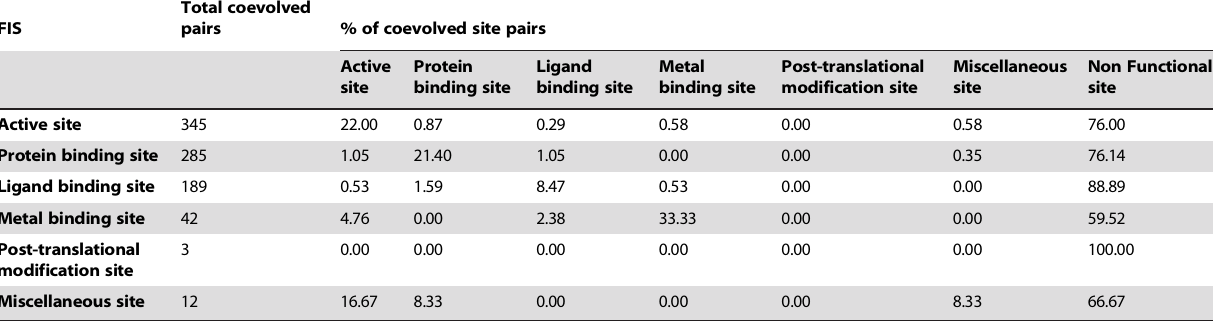
Table 3. Functional coupling of coevolved